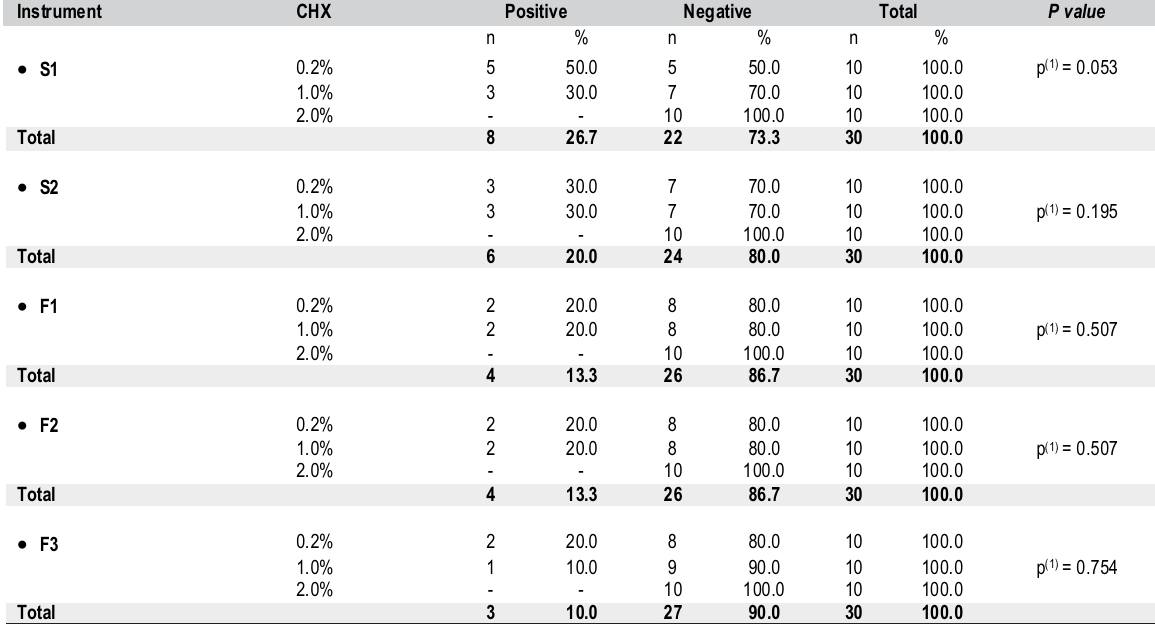
n=number of specimens (1): Fisher exact